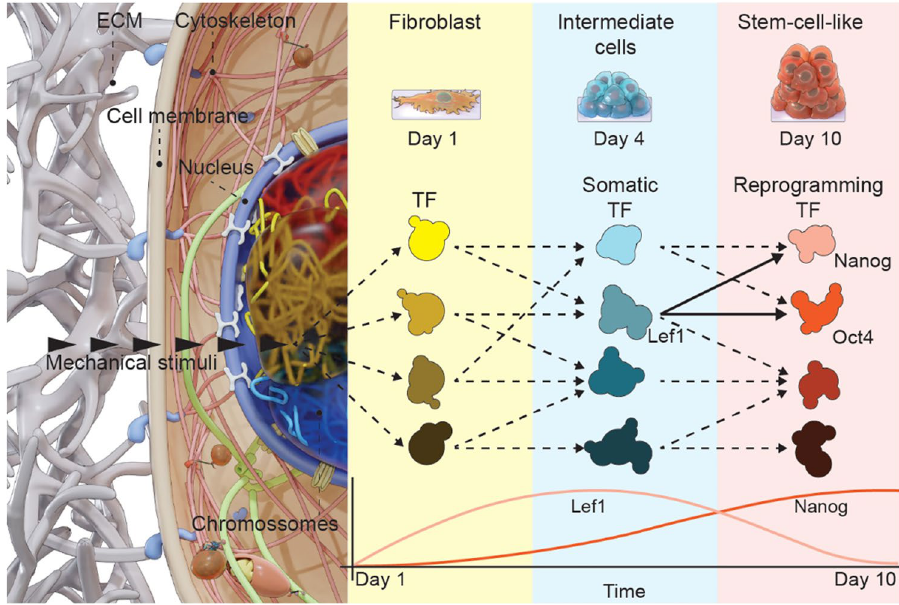
Figure 6. Schematic representation of the molecular mechanism of laterally confined growth induced fibroblast